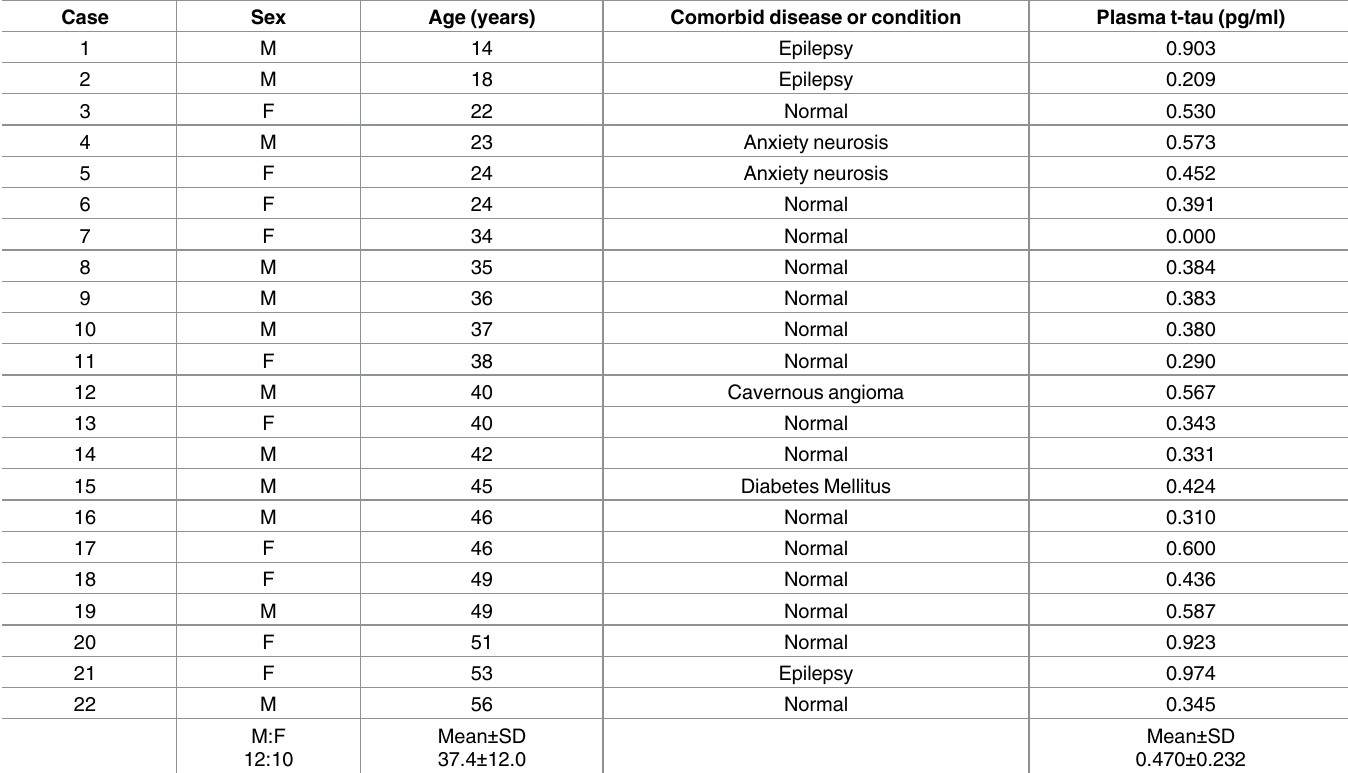
Table 1. Concentrations of plasma t-tau in the control